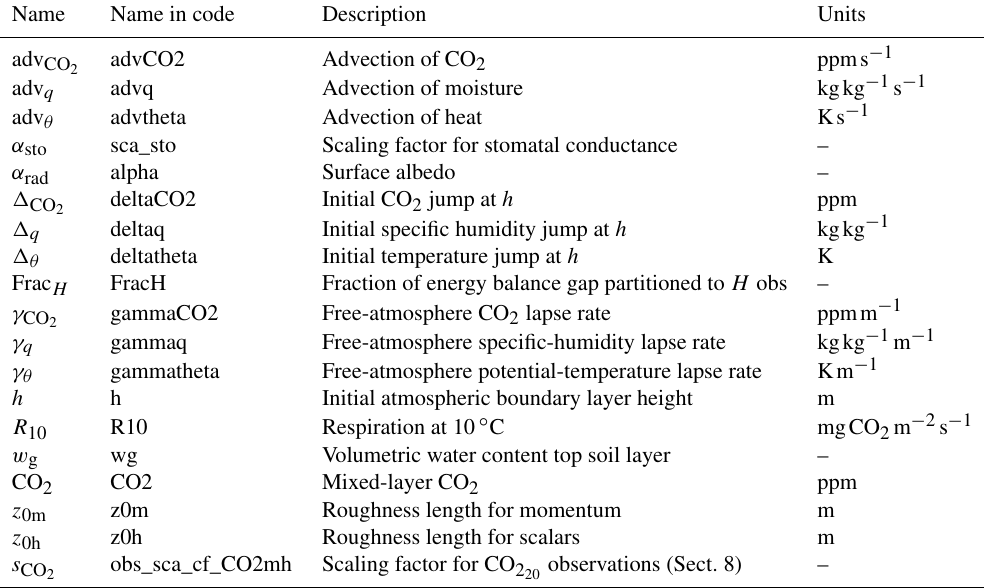
Table A1. Used parameters in this paper.